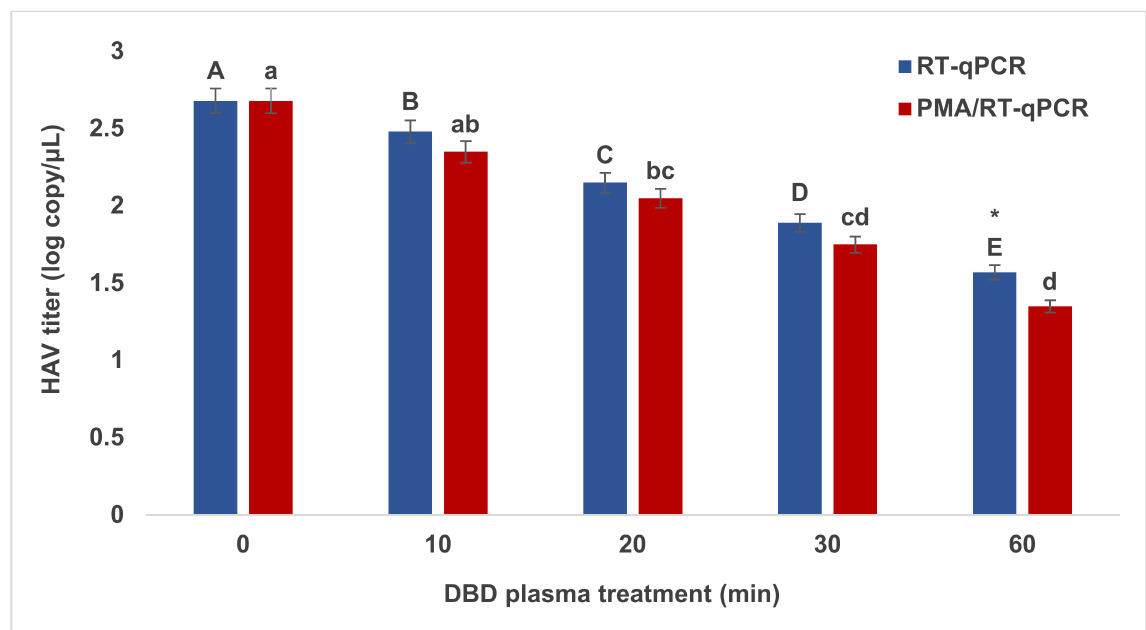
Figure 3. Comparison of HAV values in oyster between RT-qPCR and PMA/RT-qPCR analysis by DBDP. Error bars indicate standard deviations of the mean of three samples per treatment. The different letters indicate significant differences at untreated samples (A–E) or PMA-treated samples (a–d) using Duncan’s multiple range test ( p < 0.05). Asterisk (*) indicates a significant difference between untreated and PMA-treated samples by t -test ( p < 0.05).